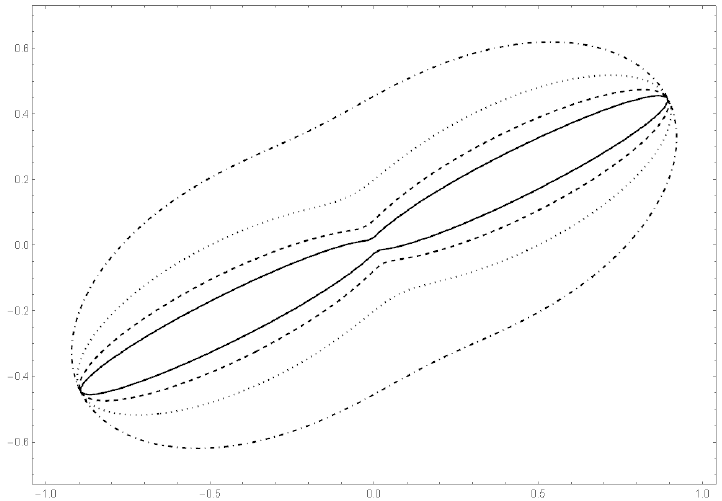
Figure 5. Plot of the boundaries of K for a 2 = 2 in the cases a 1 = 10 (solid line), a 1 = 3 (dashed line), a 1 = 1 (dotted line) and a 1 = 0.3 (dashed/dotted